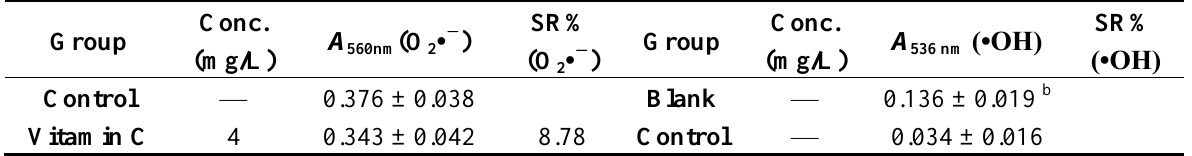
Table 3. The scavenging effect of APS on O means ± S.D. and statistical differences between groups were analyzed by one-way analysis of variance